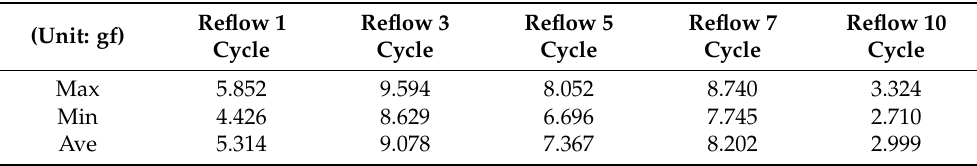
Table 11. Maximum/minimum shear force per reflow